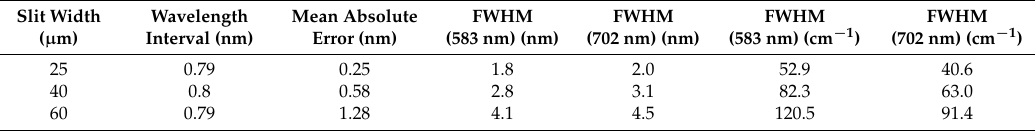
Table 2. Results of the spectral calibration of the Laser-HSI.